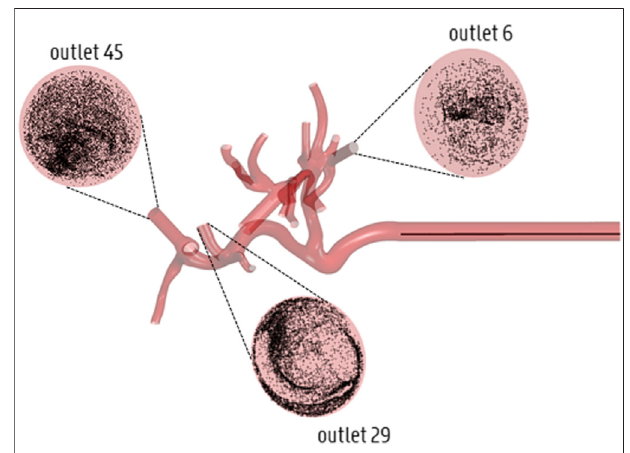
FIGURE 11 | Illustration of the spread of particles across the cross- section by the time they reach the outlets of Geometry 3 (displayed here for Catheter Location